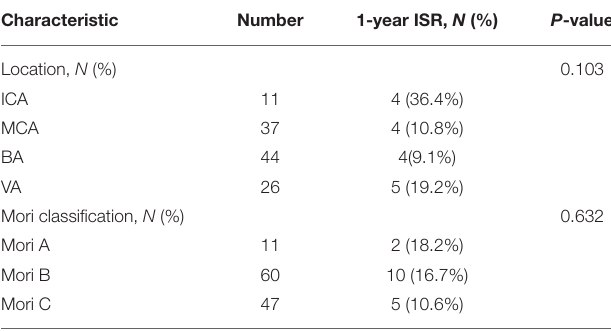
TABLE 3 | Stratification of the 1-year ISR according to the stented artery and the Mori type.